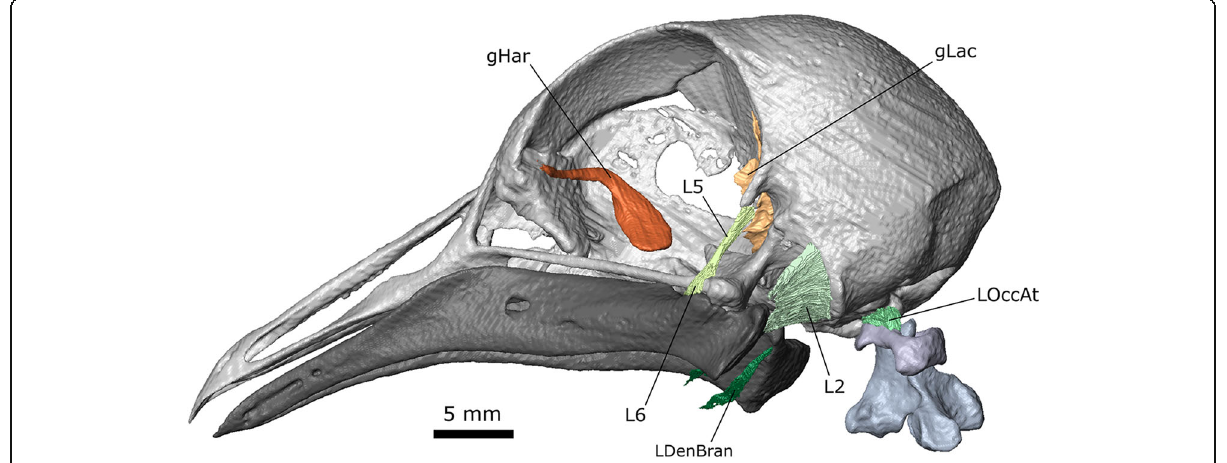
Fig. 5 Glands and ligaments of the head of Columba